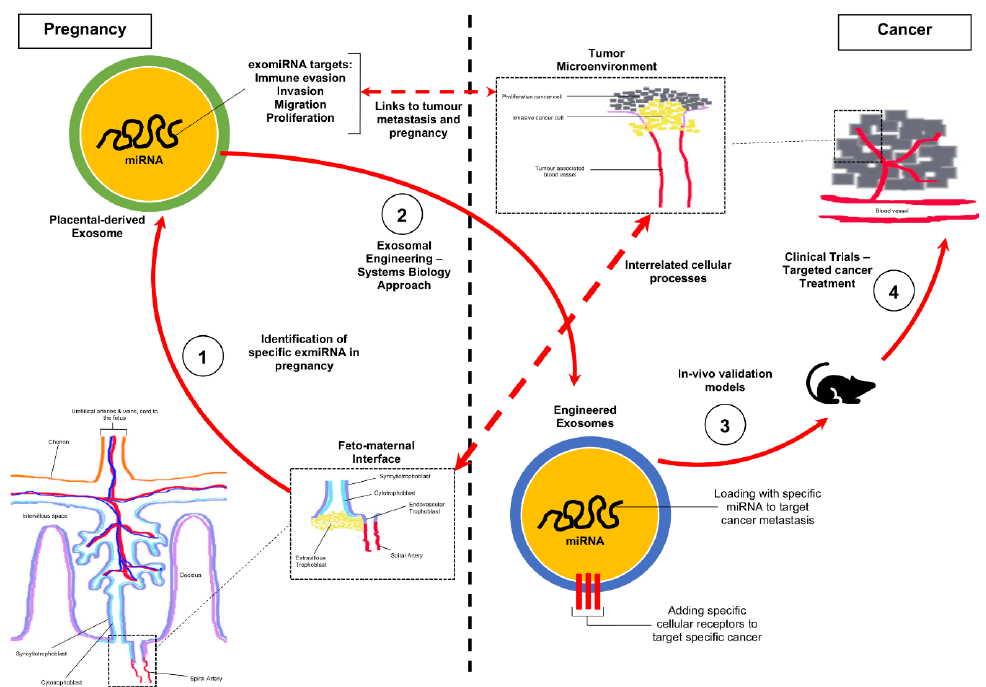
Figure 3. Strategy for the repurposing of pregnancy-associated exomiR for the treatment of cancer. Schematic representation of the development of targeted cancer therapeutics using interrelated exomiR biological mechanisms identified in pregnancy. (1) Our study has identified novel exomiR in pregnancy which is linked to cancer biological processes such as immune evasion, migration and